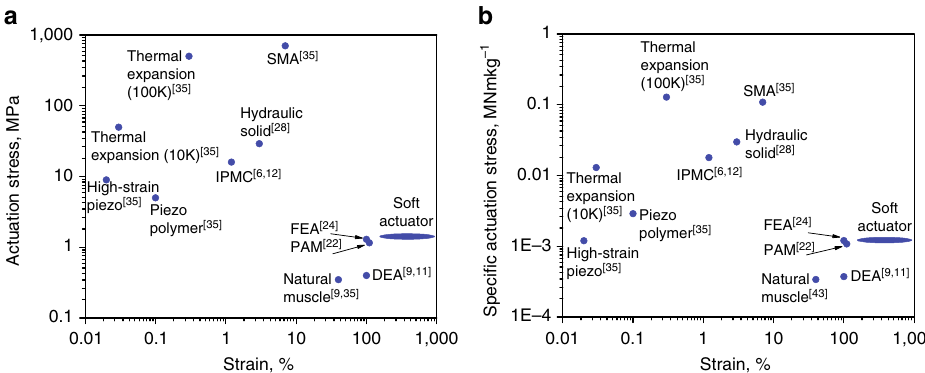
Fig. 5 Comparative stress-strain charts for electrically driven actuators. a Actuation stress plotted against strain. b Speci fi c actuation stress (actuation stress divided by density of the material) plotted against strain. Abbreviations: DEA- dielectric elastomer actuator, FEA- fl uidic elastomer actuator, IPMC- ionic polymer-metal composite, PAM- pneumatic arti fi cial muscle (McKibben actuator), SMA- shape memory alloy. The proposed material is labeled “ Soft Actuator ” . The ellipse designates a range of observed strains spanning from constrained unidirectional expansion of 140% to unconstrained volumetric expansion of 900%. For Thermal Expansion actuators, 10 and 100 K are the temperature change ranges in Kelvin degrees